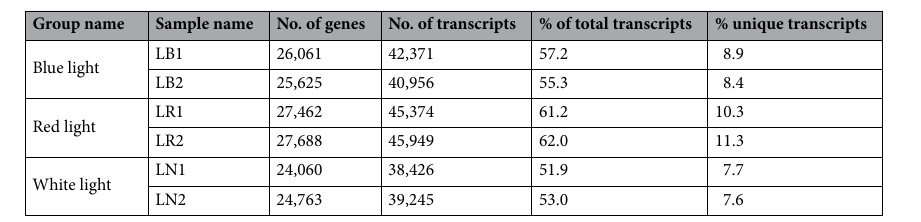
Table 4. Number of genes and transcripts expressed (minimum TPM of 1) in lettuce leaves grown under different light conditions.